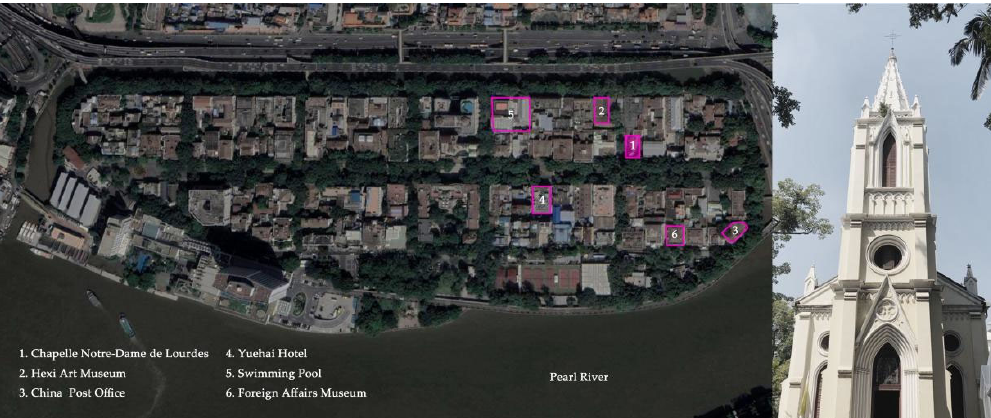
Figure 1. Location and Surroundings of Chapelle Notre ‐ Dame de Lourdes (CNDL).